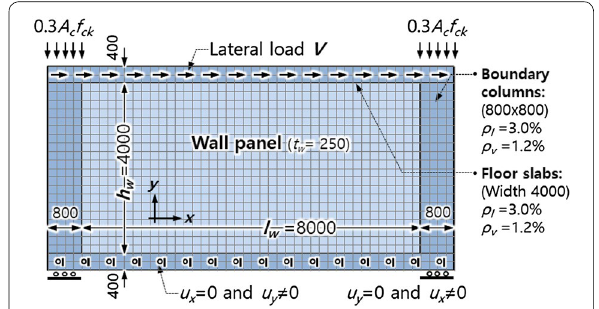
Fig. 13 PSC belt wall specimen for finite element analysis (mm).